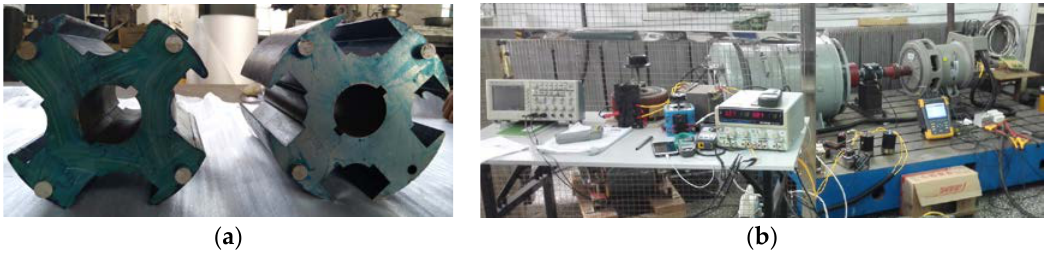
Figure 10. Photographs of the test rigs. ( a ) Symmetrical and asymmetrical rotor lamination; ( b ) Test rigs.